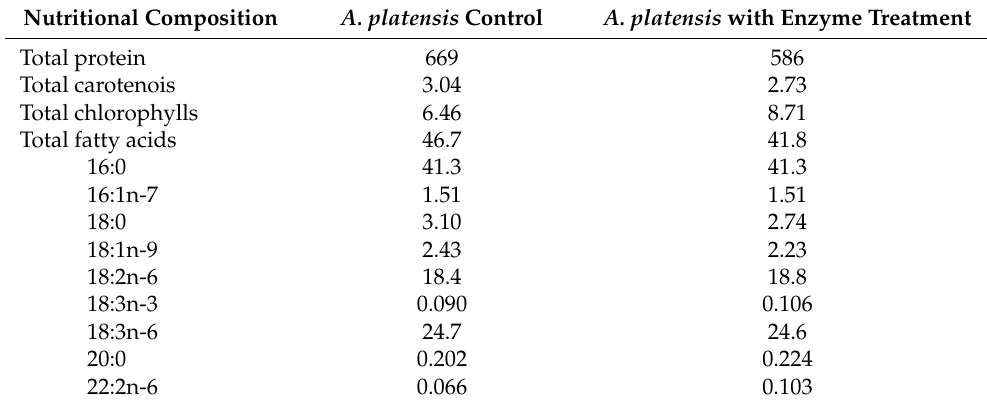
Control: A. platensis suspension incubated with PBS, Enzyme treatment: A. platensis suspension incubated with mix of